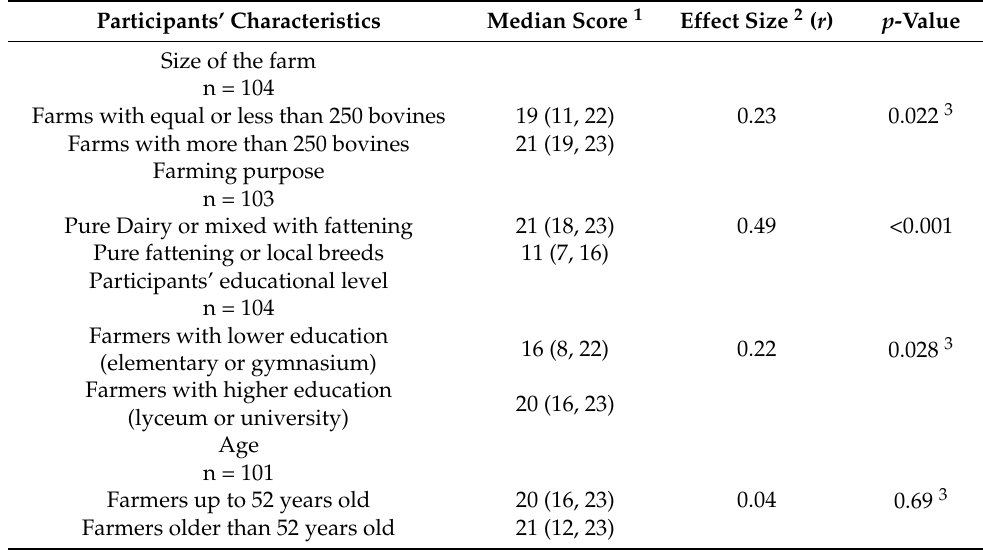
Table A2. Comparison of farmer groups with different demographic characteristics to the total knowledge score about safe manure